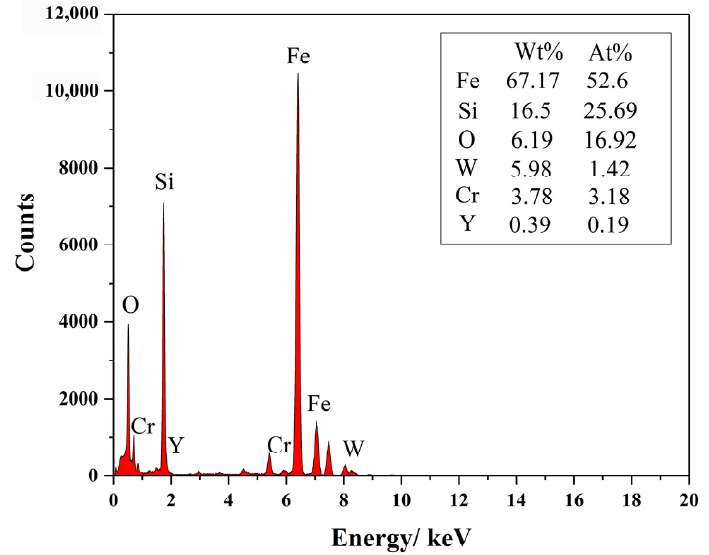
Figure 8. EDS analysis at the center of the microparticle in the 1280-S3 ODS steels (red point in Figure 7).